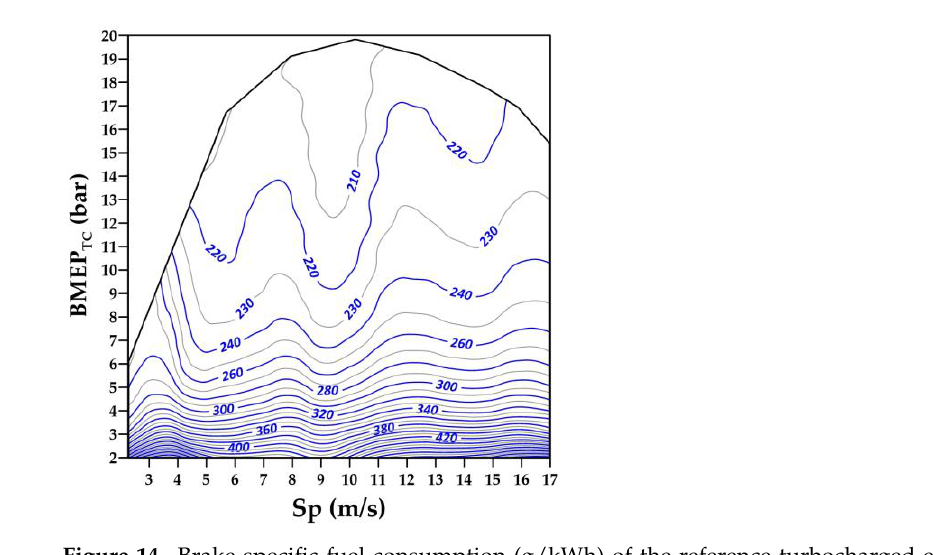
Figure 16. Comparison between the best efficiency curves of the realistic compound engine com- pared to the reference traditional turbocharged engine.